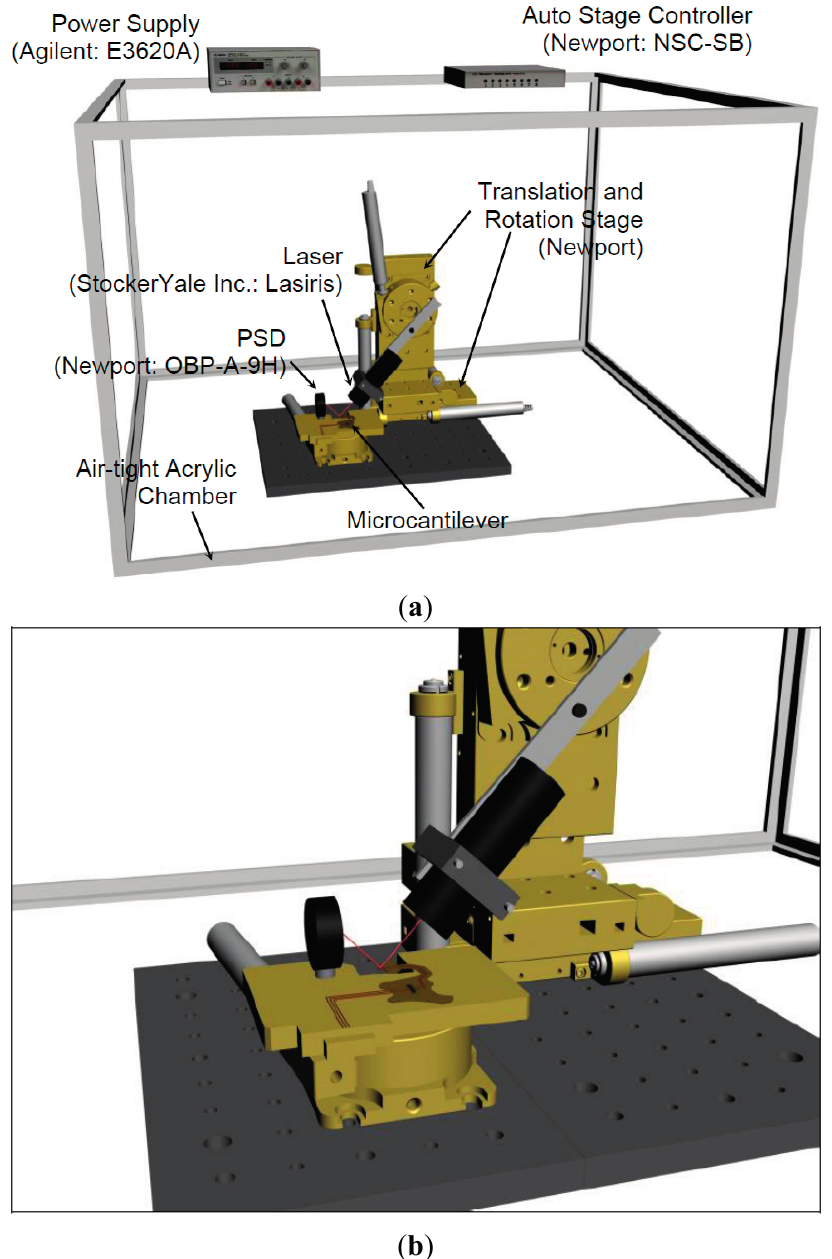
Figure 5. Schematic of the experimental apparatus based on the optical-lever method used in this study for explosive detection: ( a ) experimental setup for detection; and ( b ) sensing of reflected light using